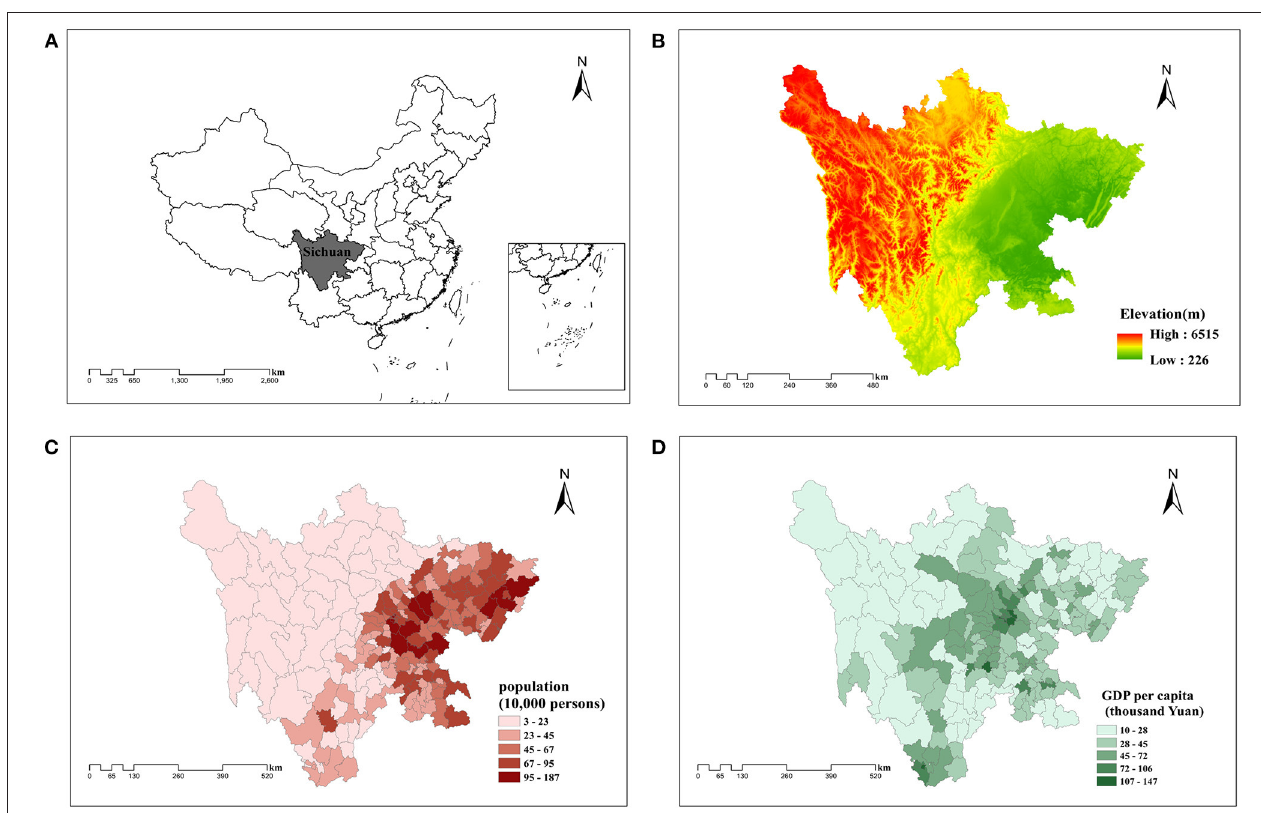
FIGURE 2 | (A) Geographic position, (B) topography, (C) demography, and (D) economic development in Sichuan Province, China. The data for geographic position and topography are from AutoNavi. Copyright 2021 by Amap.com. The data for demography and economic development are from The Statistical Yearbook of Sichuan Province, by Sichuan Provincial Bureau of Statistics, 2019 (http://tjj.sc.gov.cn/tjnj/cs/2019/zk/indexch.htm). Copyright 2021 by China Statistics